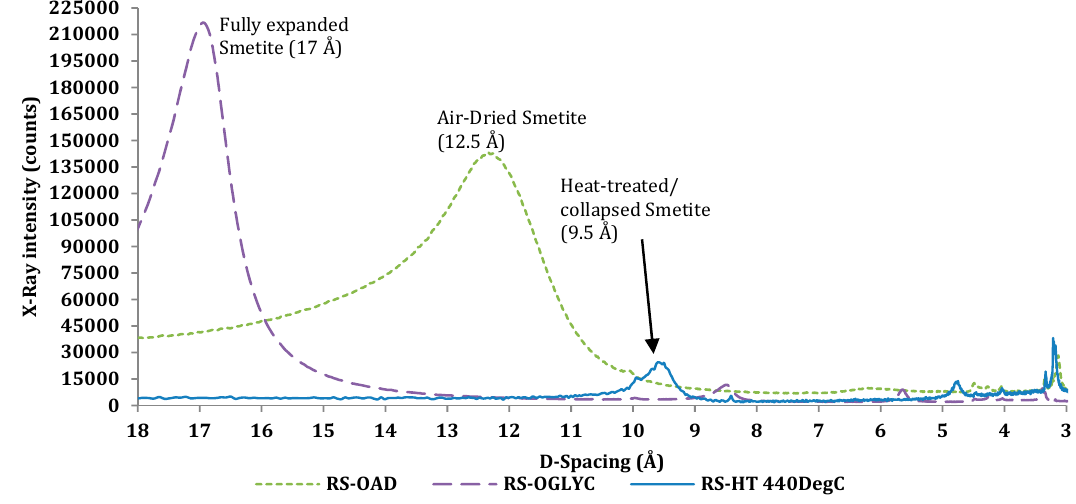
Figure 5. Oriented air-dried, glycolated heat-treated XRD on the MX80.